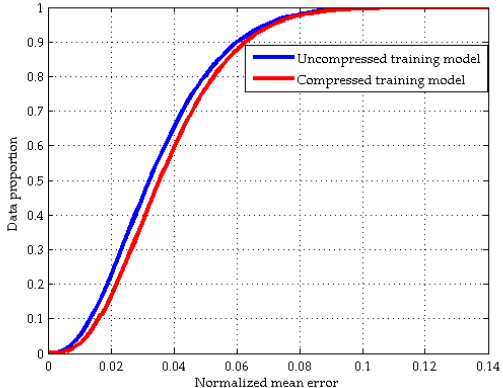
Figure 11. Comparison of the cumulative error distribution curves between our compressed training model SDM and the uncompressed training model SDM [6] on the 300 W test set [12].